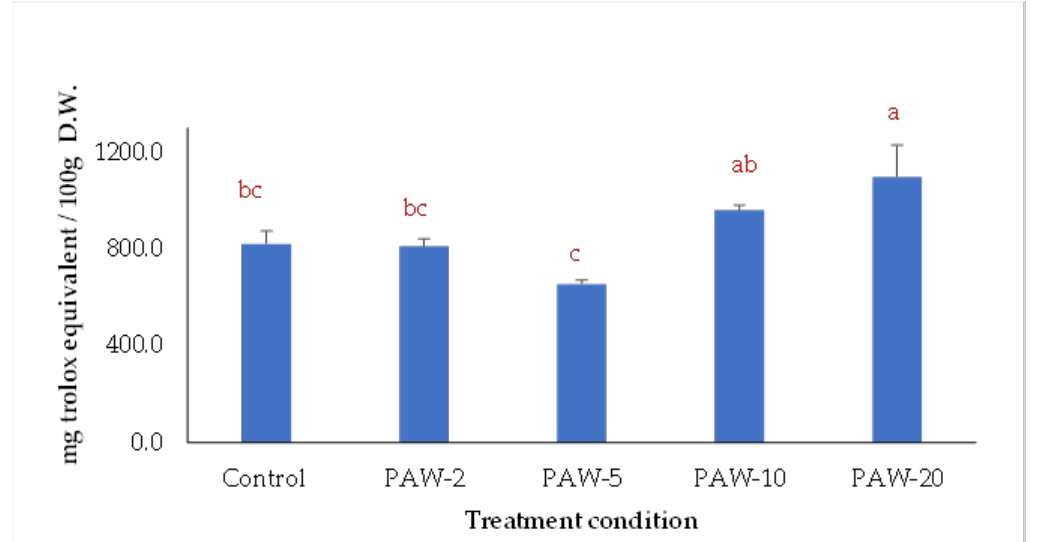
Figure 3. DPPH reducing activity expressed as mg trolox equivalent (TE)/ 100 g dry weight (D.W.) of plant material of PAW- treated rocket samples at different treating times compared to control samples. Means that do not share letters differ significantly ( p < 0.05) according to Tukey’s test.PAW-2, PAW-5, PAW-10, and PAW-20 refer to rocket samples subjected to plasma-activated water (PAW) treatment for 2, 5, 10, and 20 min, respectively.